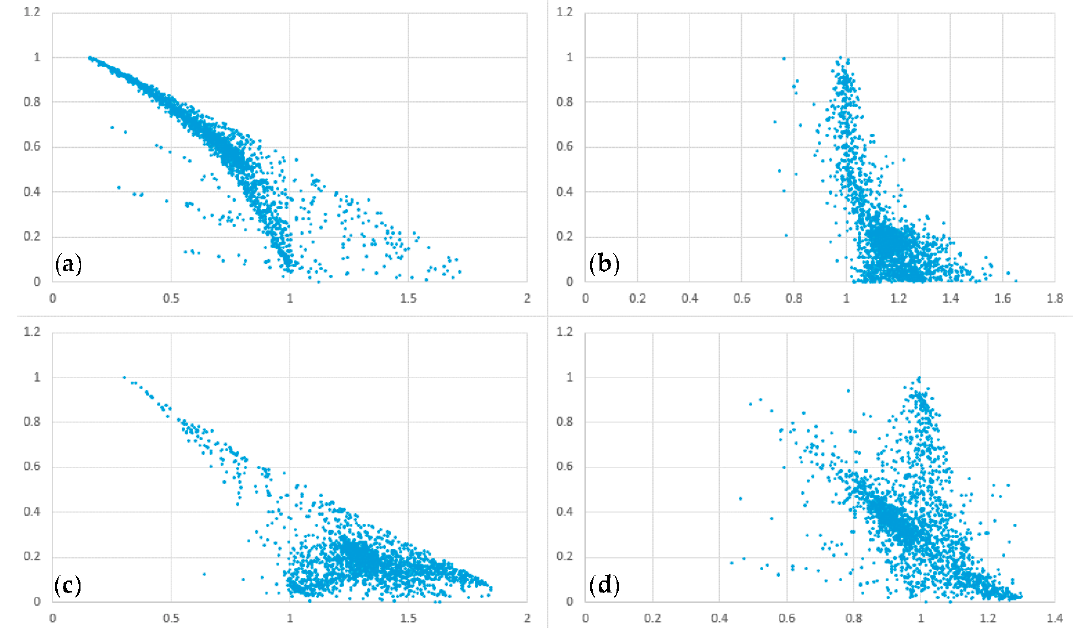
Figure 10. Distance vs. value plot for RadViz for ( a ) Gd; ( b ) Ce; ( c ) Co and ( d ) Fe.